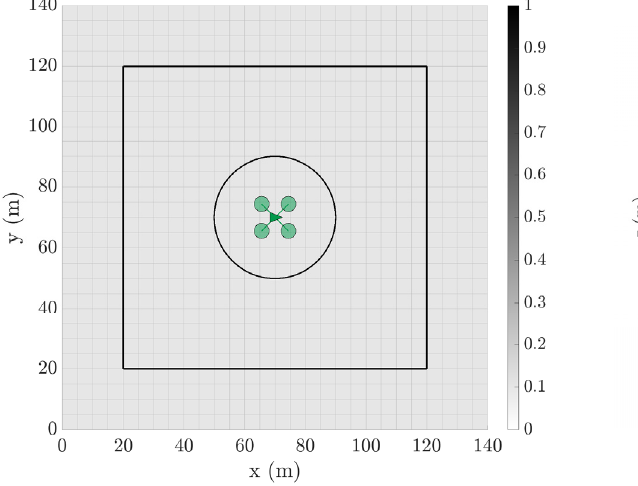
at all, as in Figure 4a. as in Figure